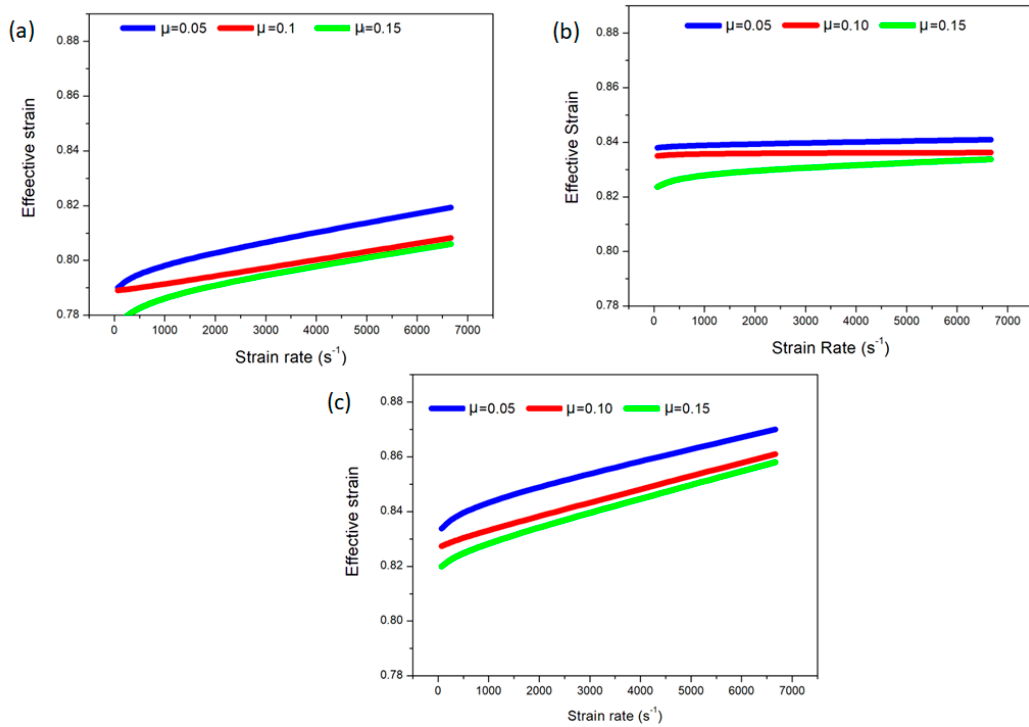
Figure 8. Effective strain at ( a ) 25 °C; ( b ) 250 °C; ( c ) 500 °C.